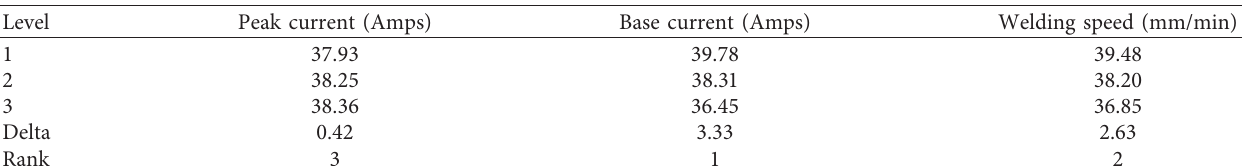
Table 9: Response table for S/N ratio (tensile strength) (larger is better).